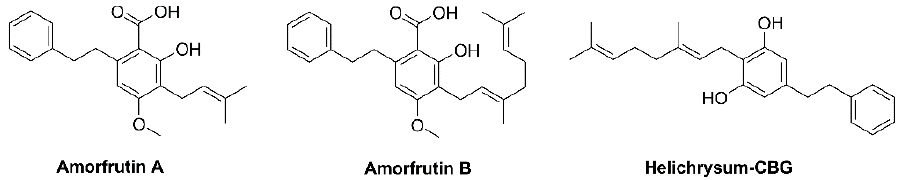
Figure 2. Structure of phytocannabinoids in Helichrysum and Glycyrrhiza plants.